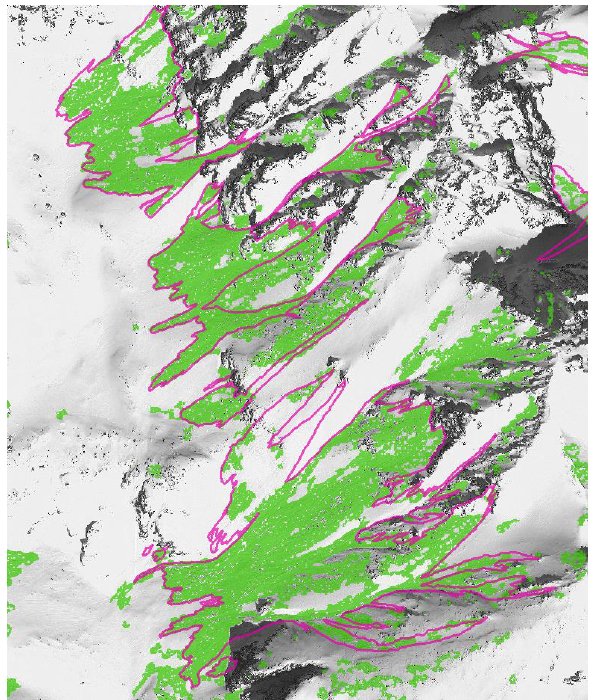
Figure 7b: Qualitative comparison between expert mapping and algorithm performance: manually digitized avalanche outlines (in pink) superimposed on the automatically classified avalanches (in green). (Satellite image: Copyright ©